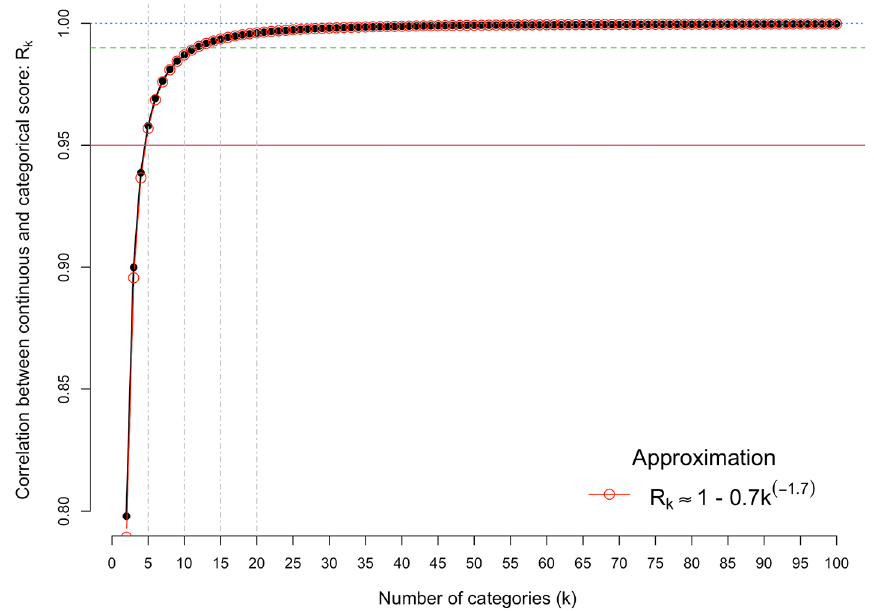
Figure 2. Correlation between the observed categorical score and the underlying continuous score. The x-axis is the number of discrete categorical scores (k) and the y-axis shows the correlation between the observed categorical score (Y) and the underlying continuous score (u). The red horizontal line denotes a correlation of